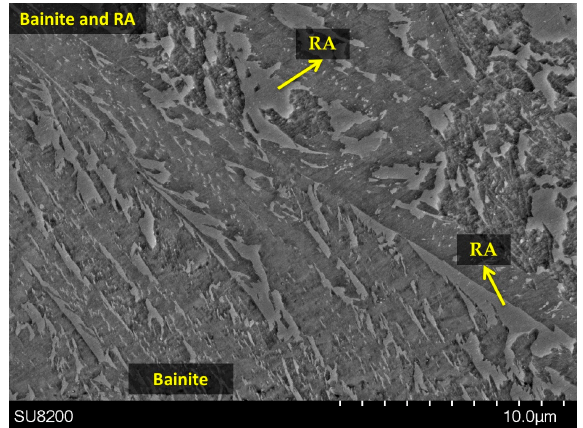
Figure 1. SEM (scanning electron microscope) image illustrating as-received microstructure composed of bainite and retained austenite (RA).